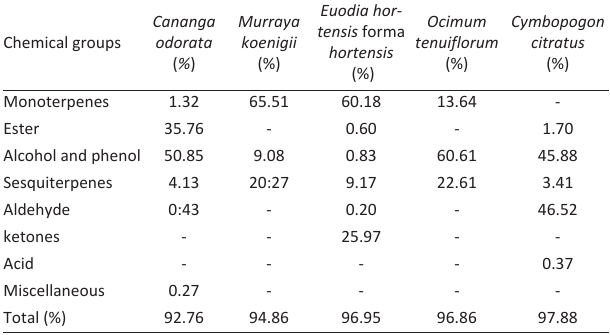
Table 2 - The major chemical groups present in the essential oils of C. odorata , M. koenigii , E. hortensis , O. tenuiflorum